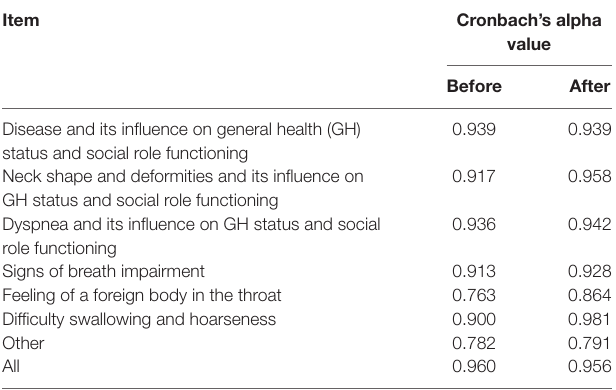
TaBle 3 | Cronbach’s alpha values for Thyroid-Related Health-Related Quality of Life before and after treatment. item cronbach’s alpha